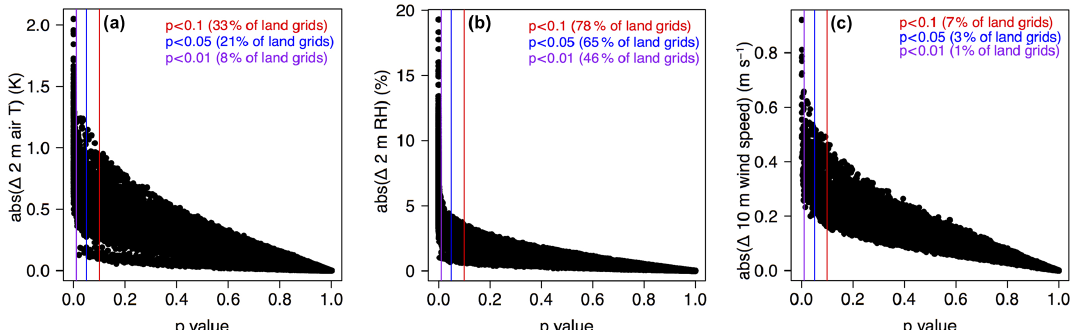
Figure 4. The p values of Student’s t tests comparing the daytime (a) 2m air temperature ( T ); (b) 2m relative humidity (RH); and (c) 10m wind speed from the base and assim cases, plotted against the absolute changes in these model fields due to the SMAP DA. Results are only presented for the overland model grids.